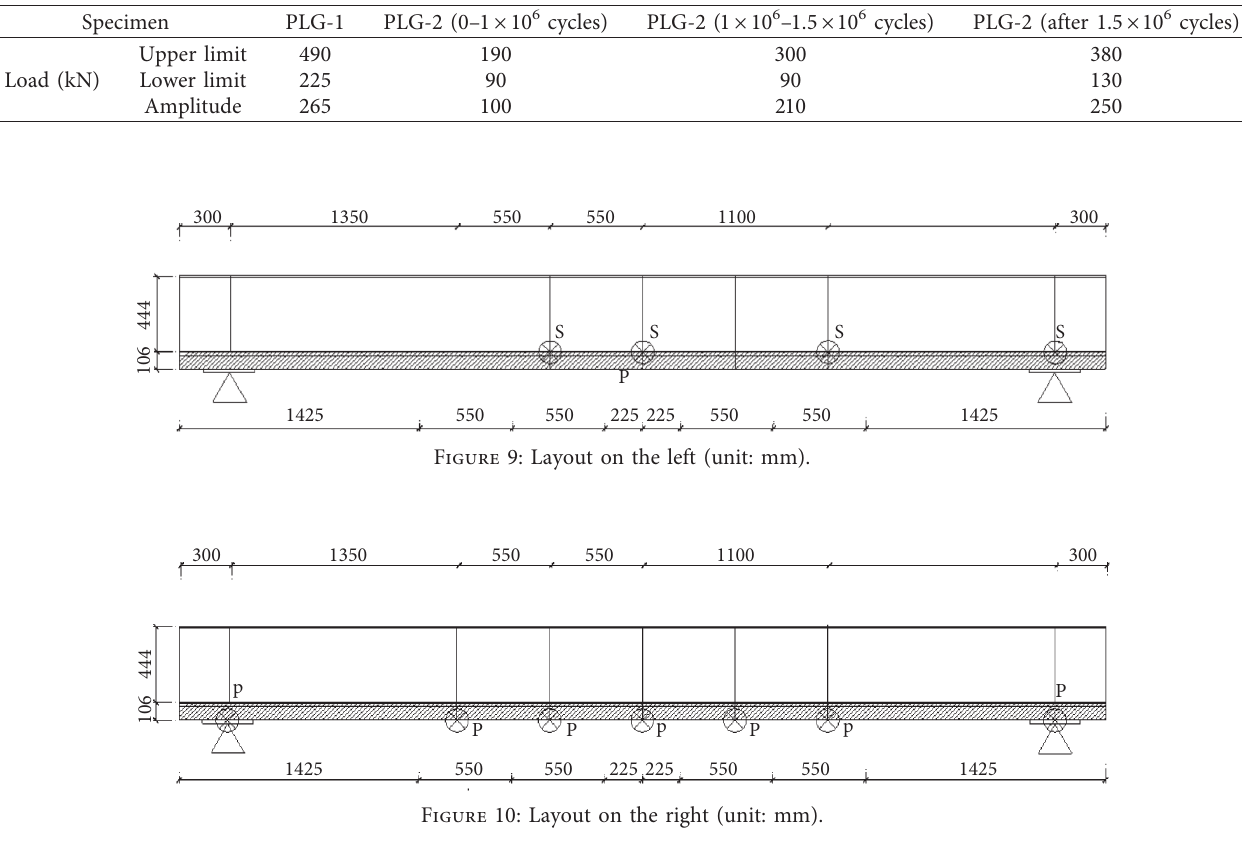
Table 3: Test load.